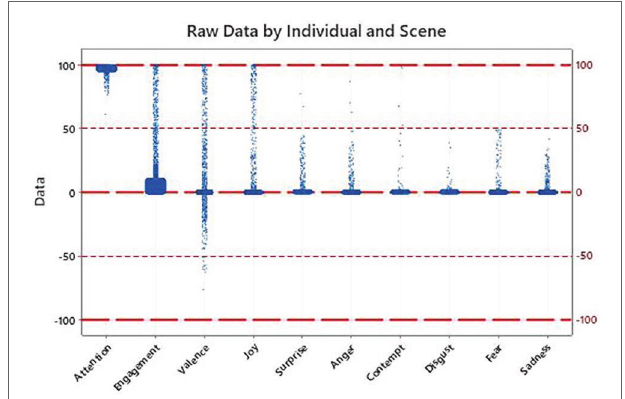
FIGURE 2 | Descriptive plot for the whole sample by emotional